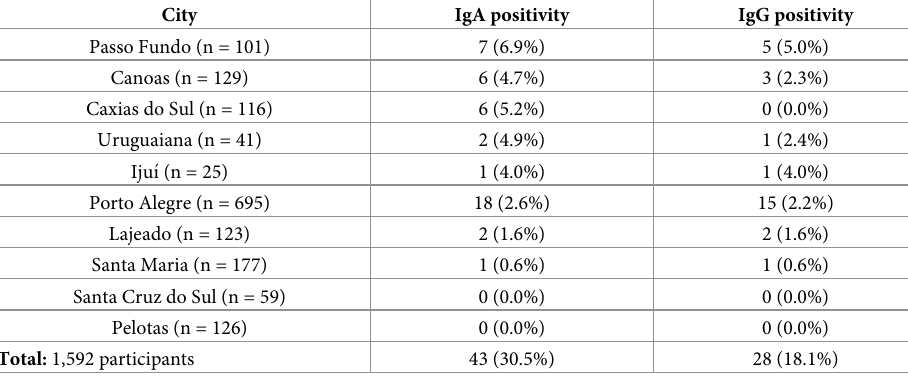
Table 1. Marked variability in COVID-19 seroprevalence according to the city of origin in a survey of military police workers in the South of